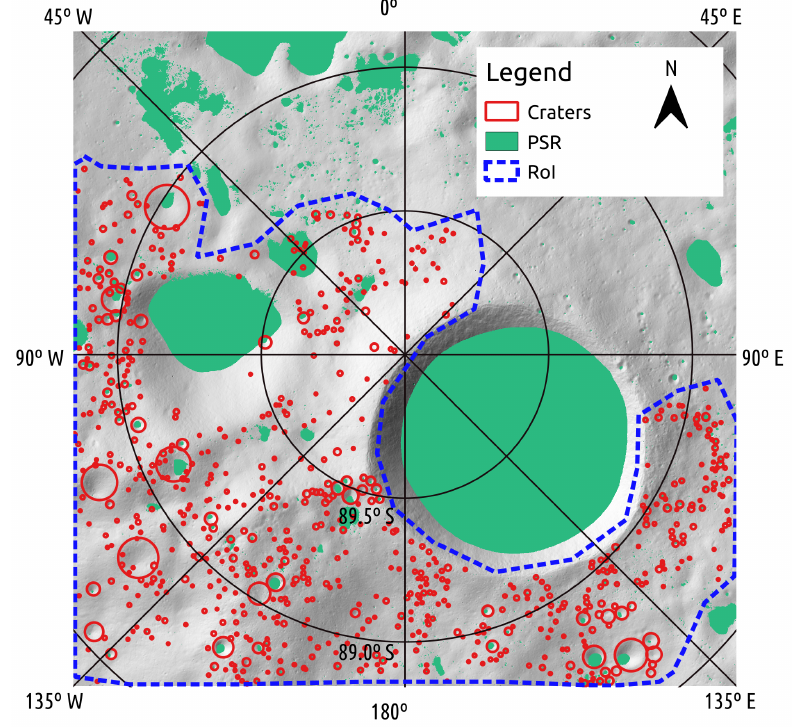
Figure 4. Selected craters after filtering (red) with the Permanent Shadowed Regions (PSRS) (green) and the RoI (blue). One large PSR can cover several small